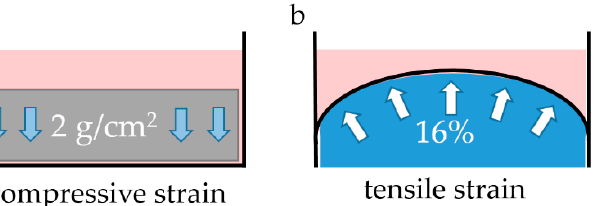
Figure 4. Schematic representation of the application of static pressure (2 g/cm 2 , a ) and tensile strain (16%, b ) for 4 h. strain (16%, ( b )) for 4